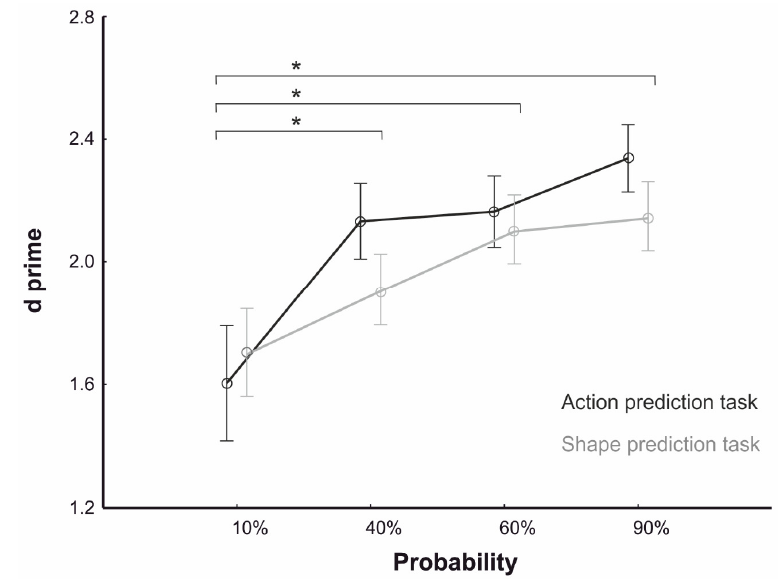
Figure 2. Behavioral results. Participants’ performance in predicting the action (black line) and the shape identity (grey line) for the four probability conditions (10%, 40%, 60%, 90%) expressed as d’. Data points represent group averages. Asterisks indicate significant comparisons ( p < 0.05). Error bars represent SEM.